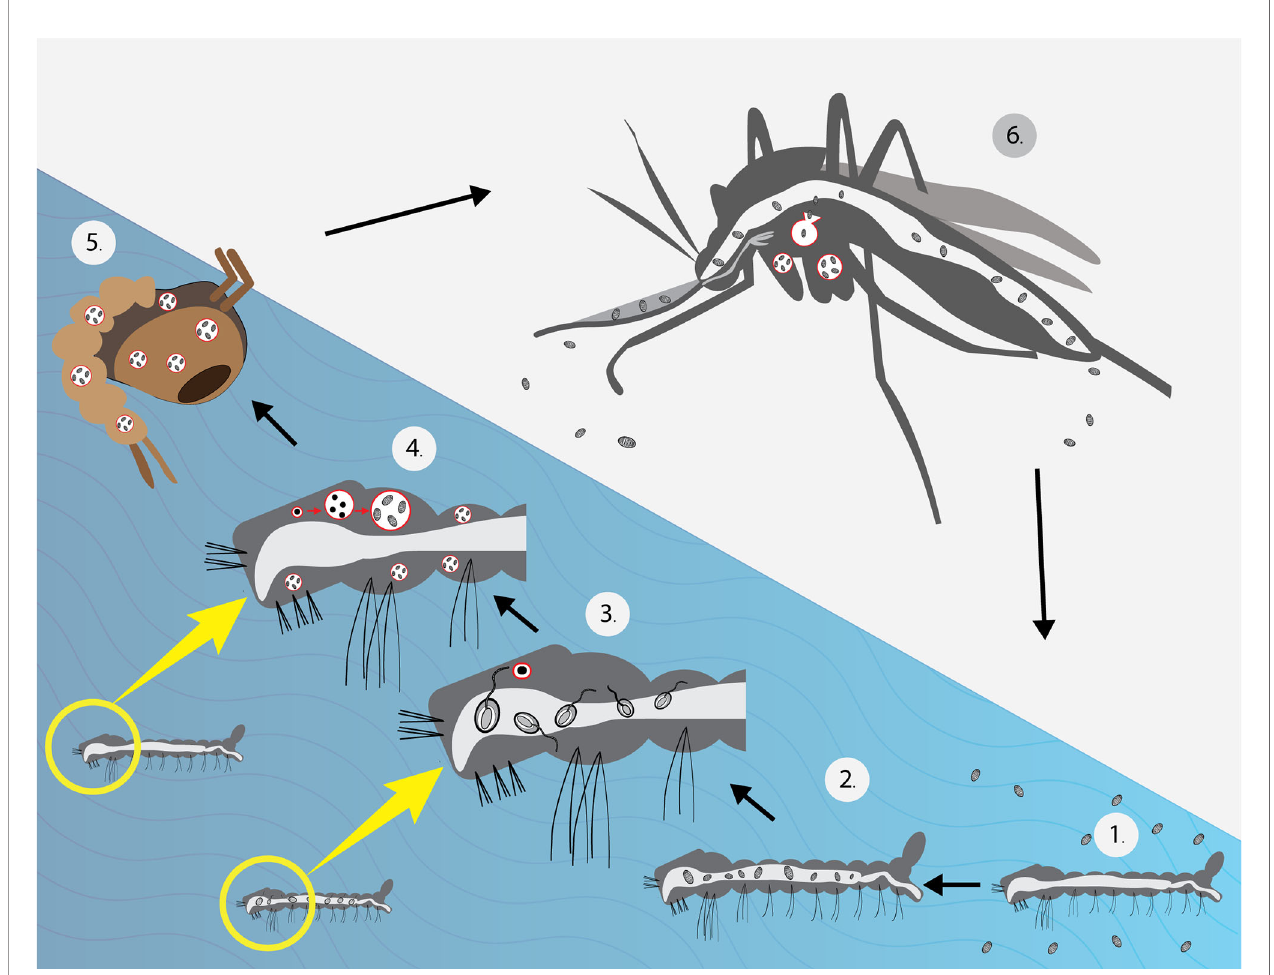
FIGURE 1 | Life cycle of T. hominis under laboratory conditions (Weidner et al., 1999). (1) Larvae were placed in water with T. hominis spores. (2) Spores observed in the gut (3). After several hours, the majority of spores germinated (4). After 1 week, the larvae matured into 3 rd instars and showed signi fi cant infection in their muscles. (Merogony and sporogony occurred during this stage) (5). Almost all microsporidia reached the spore stage before developing into pupae. (6) Spores were found in muscles, hemocoel, proboscis and, the cecal region. A low number of spores was detected in sugar water during feeding. The mosquito image here was taken from